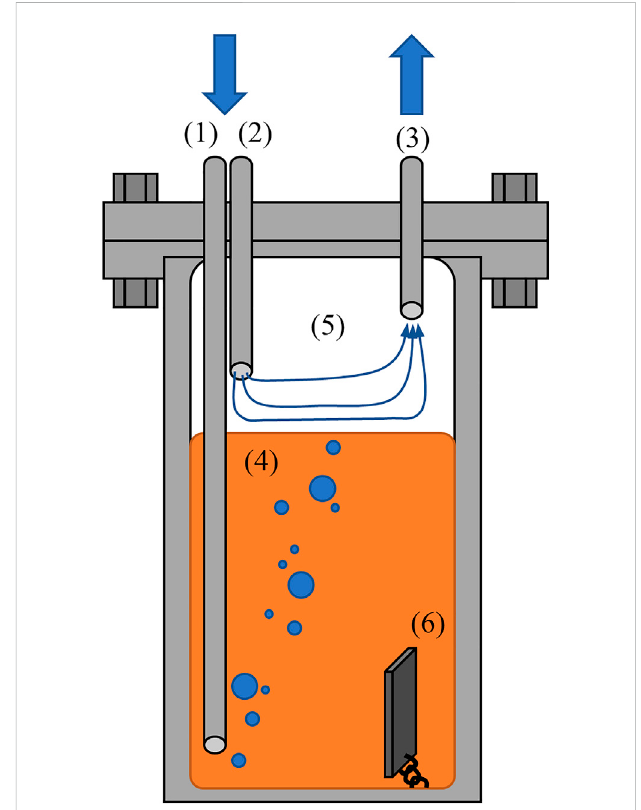
FIGURE 1 Example schematic of salt test capsule with (1) sparge gas line to bubble gases through salt, (2) cover gas line to sweep salt gas interface, (3)gasoutlettosendstreamtoinlinemeasurementsystems,(4) fl uoride/ chloride molten salt, (5) capsule headspace, and (6) potential corrosion coupons or graphite